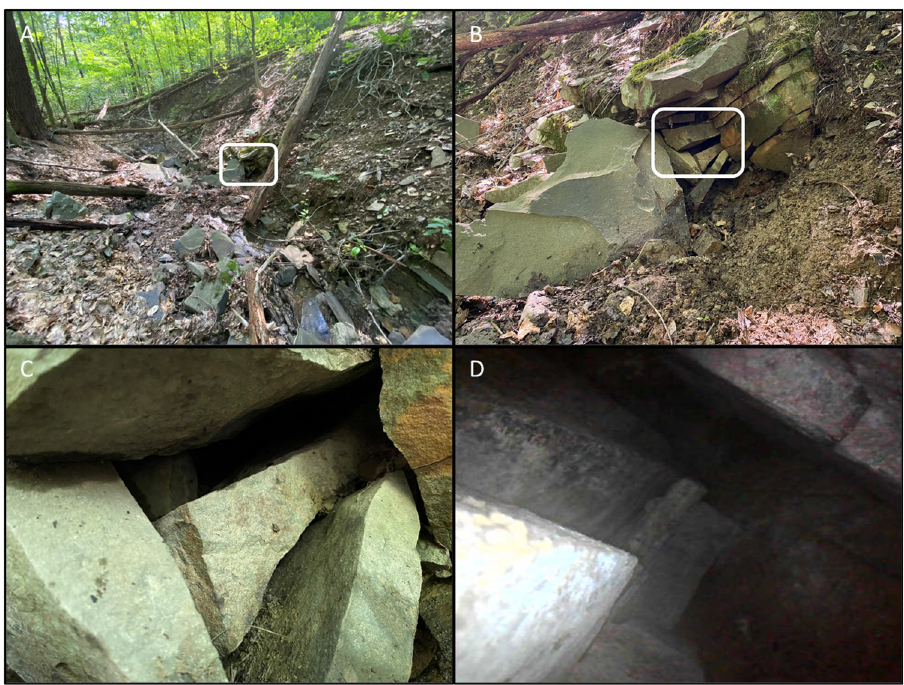
Fig 2. Northern myotis underground roost. Photographs of an underground roost in the Milieu Souterrain Superficiel used by male and female northern myotis between October and March, presumably as a hibernaculum. The white boxes in Panels A and B indicate the areas enlarged in the following panel (Panels B and C). The entrance to hibernaculum was a gap between adjacent rocks that were covered in soil within a narrow drainage. Examination of the main entrance with a borescope found air filled voids extending at least 1 m into the hillside, beyond which we could not explore (D). https://doi.org/10.1371/journal.pone.0270478.g002 (male versus female versus random tree) included stand BA , DistWater , and Decay . No other model had a Δ AICc < 2 (S1 Table). This model accounted for almost 100% of the model weight and had good fit to the data (Hosmer–Lemeshow X 2 = 15.2, df = 18, p = 0.64; area under the curve = 0.86). The probability of a tree being used by a female increased by 11% for each unit increase in BA (odds ratio = 1.11, CI = 1.07–1.16) but was not significant for males because the confidence interval for the odds ratio crossed 1 (0.99, CI = 0.95–1.03) (Figs 3 and 4). Table 1. Summary of emergence counts conducted outside an underground roost we presume to be a hibernacu- lum for northern myotis in central Pennsylvania. Month Number of Counts Counts with Bats High Count February 2 0 0 2 1 1 1 1 0